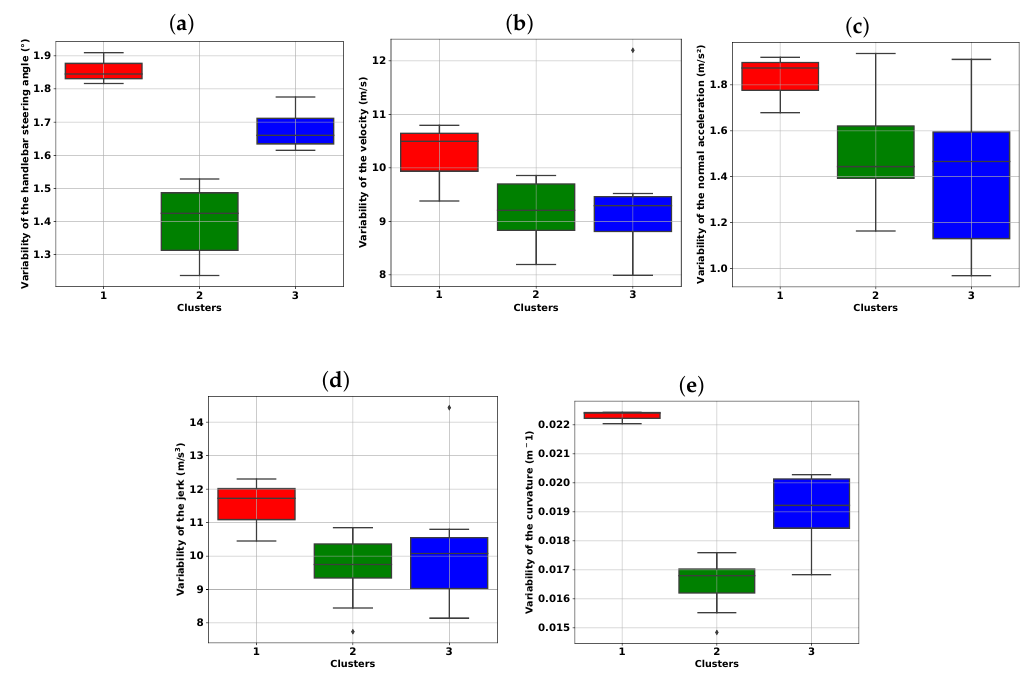
Figure 8. Distribution of the standard deviation by cluster for the five riding variables: ( a ) Handlebar steering angle, ( b ) Velocity, ( c ) Normal acceleration, ( d ) Jerk, and ( e )